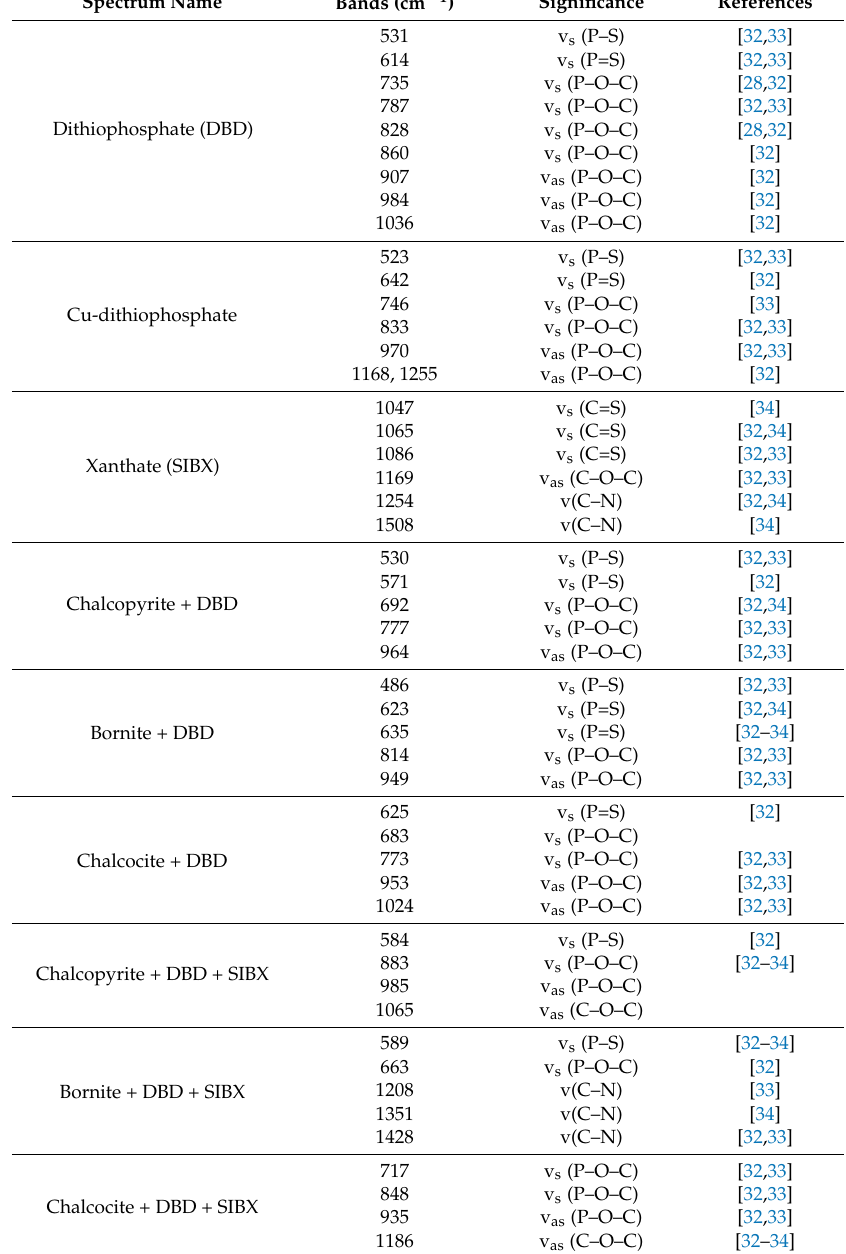
Table 1. The FTIR bands of dithiophosphate, Cu-dithiophosphate precipitate, xanthate and chalcopyrite, chalcocite and bornite (before and after adsorption of dithiophosphate/dithiophosphate-xanthate blend,